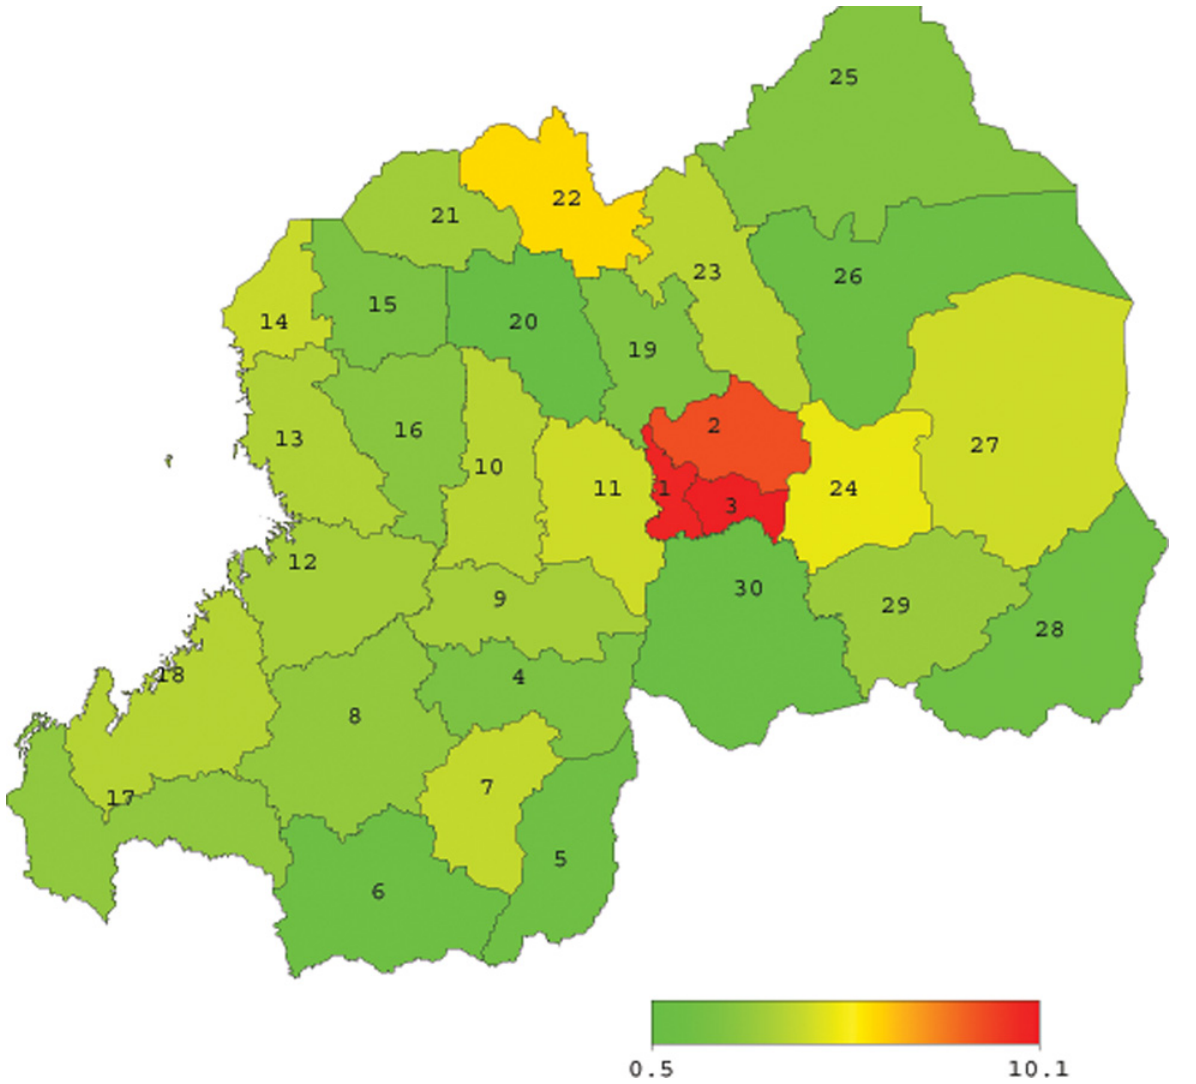
Fig 1. District codes and levels of HIV prevalence among women (15 – 49 years) in